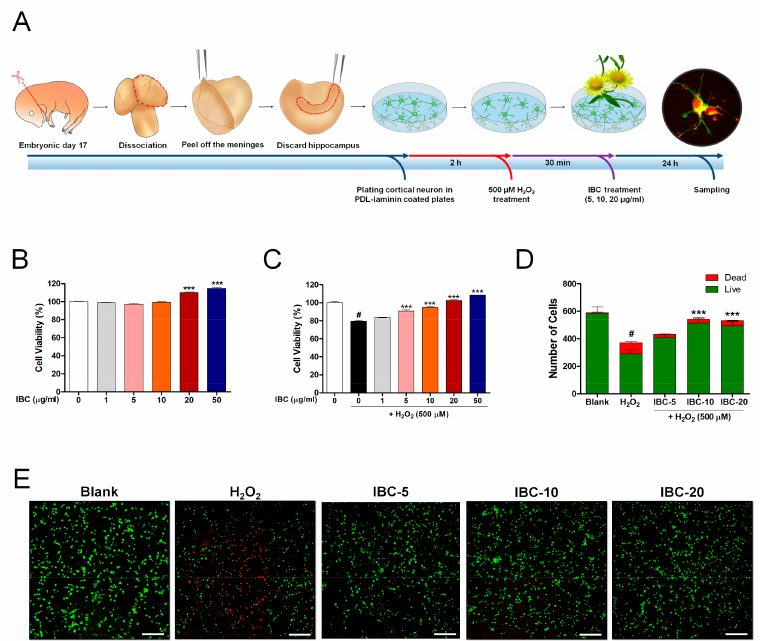
Figure 1. Inula britannica var. chinensis (IBC) extract potentially protects against H 2 O 2 -induced oxidative stress injury in rat primary cortical neurons. ( A ) Schematic drawing of the experimental protocol of a primary cortical neuron. ( B , C ) CCK-8 results of cortical neurons treated with various concentrations of IBC for 24 h with (n = 6) and without exposure to hydrogen peroxide stress (n = 4). ( D ) Quantification of the number of live and dead cells for the neurotoxicity assay (n = 5). ( E ) Cell viability was imaged with confocal microscopy using live/dead imaging assay kit (live cells, green; dead cells, red). White scale bar = 200 µ m. Data are expressed as the means ± SEM. Significant differences indicated as # p < 0.001 compared vs. the blank group, *** p < 0.001 vs. the H 2 O 2 group were analyzed via one-way ANOVA with Tukey’s post hoc